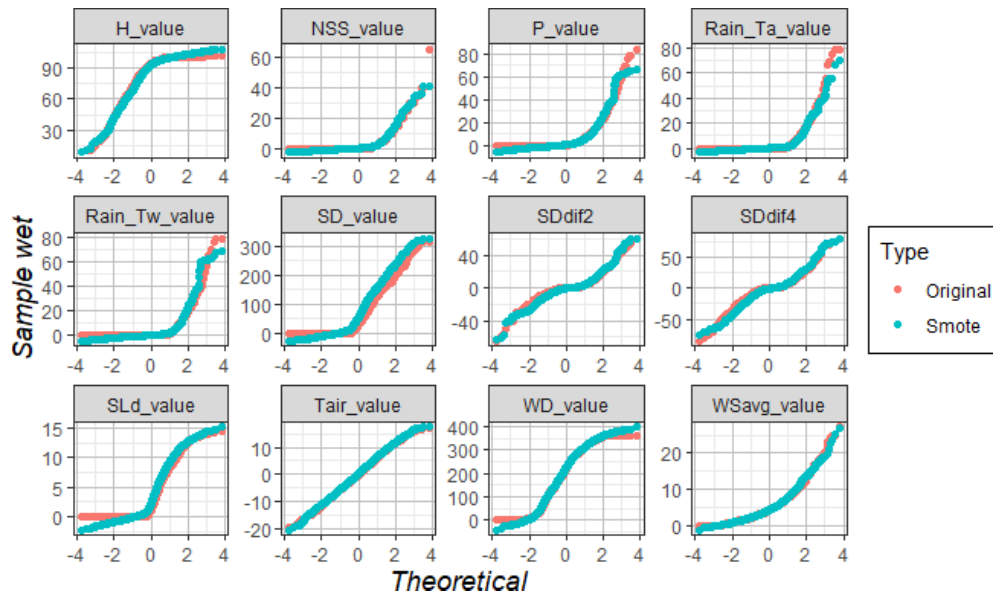
Figure A3. Quantile–quantile (Q–Q) of wet avalanches of original and synthetic data (SMOTE).